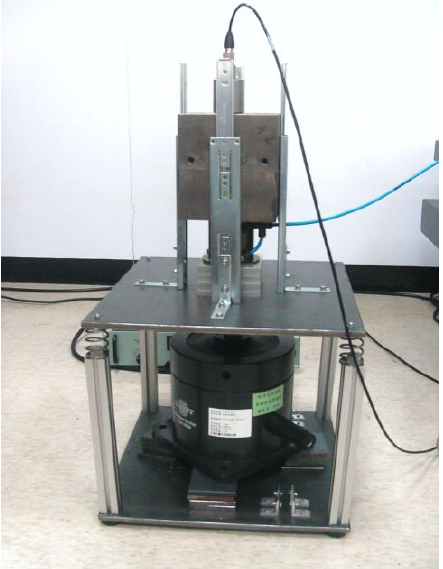
Figure 2. Photograph of the experimental